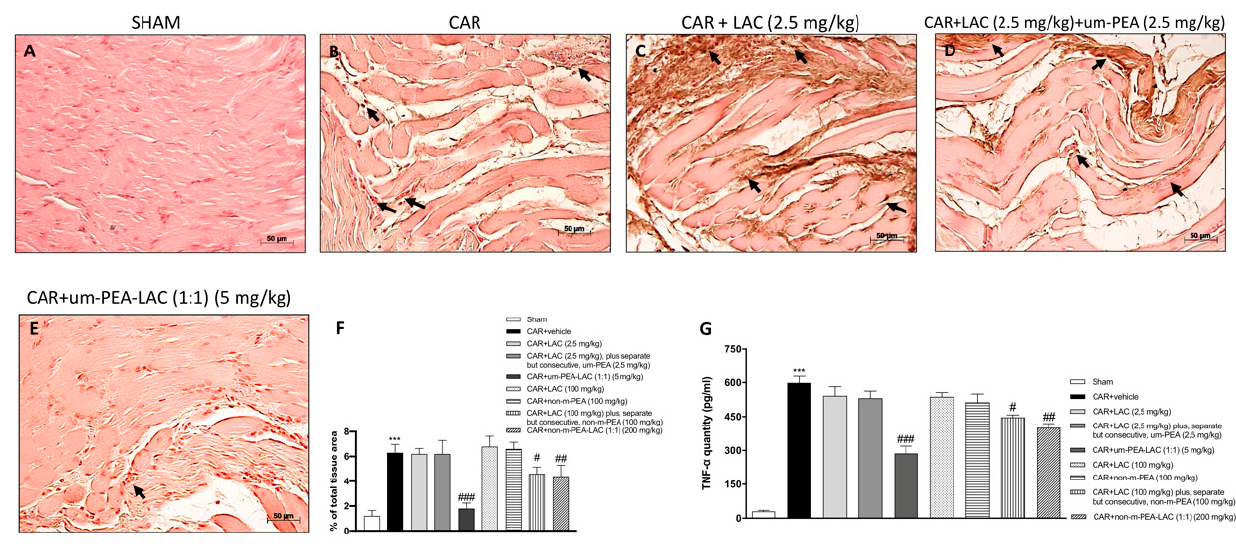
Figure 5. Efficacy of um-PEA and LAC treatment on TNF- α expression. Positive TNF- α immunostaining was found in paw tissues collected from vehicle treated rats ( B , F ), compared to the sham-treated rats ( A , F ). CAR + LAC (100 mg/kg) plus, separate but consecutive, non-m-PEA (100 mg/kg) and CAR + non-m-PEA and LAC (1:1) (200 mg/kg) treatments (data not shown), but even more um-PEA and LAC (5 mg/kg) administration reduced this staining ( E , F ). Other treatments, individually or mixed, did not show any significant reduction in TNF- α expression ( C , D , F, and data not shown). Black arrows indicate the positive staining for TNF- α . Quantification of TNF- α levels confirmed data ( G ). Data are representative of at least three independent experiments. Values are means ± SEM. One-Way ANOVA test. *** p < 0.001 vs. sham; # p < 0.05 vs. CAR; ## p < 0.01 vs. CAR; ### p < 0.001 vs. CAR.